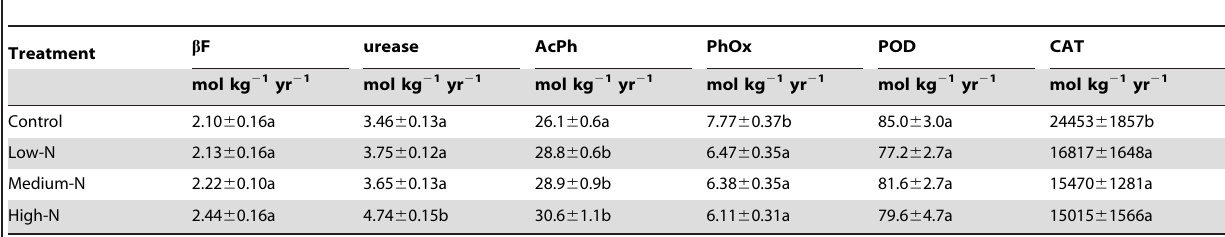
Table 1. Results of one-way ANOVAs of accumulative soil enzyme activities in a Bambusa pervariabilis 6 Dendrocalamopsis daii plantation (mean 6 SE, n